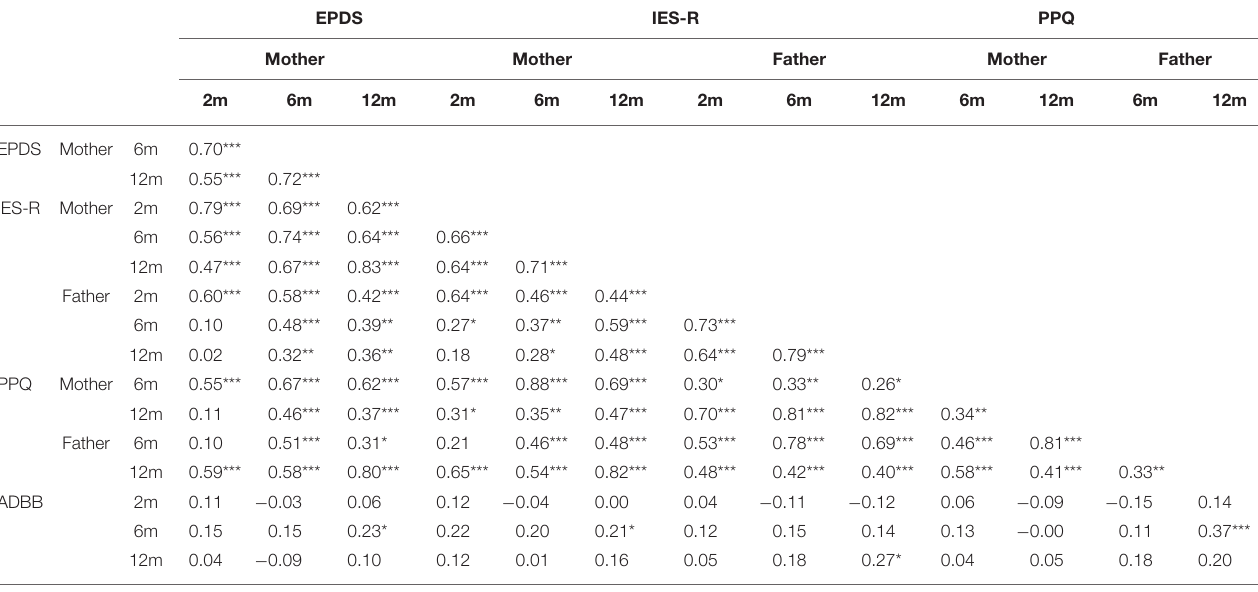
TABLE 4 | Correlations between ADBB, EPDS, IES-R, and PPQ scores at 2, 6, and 12